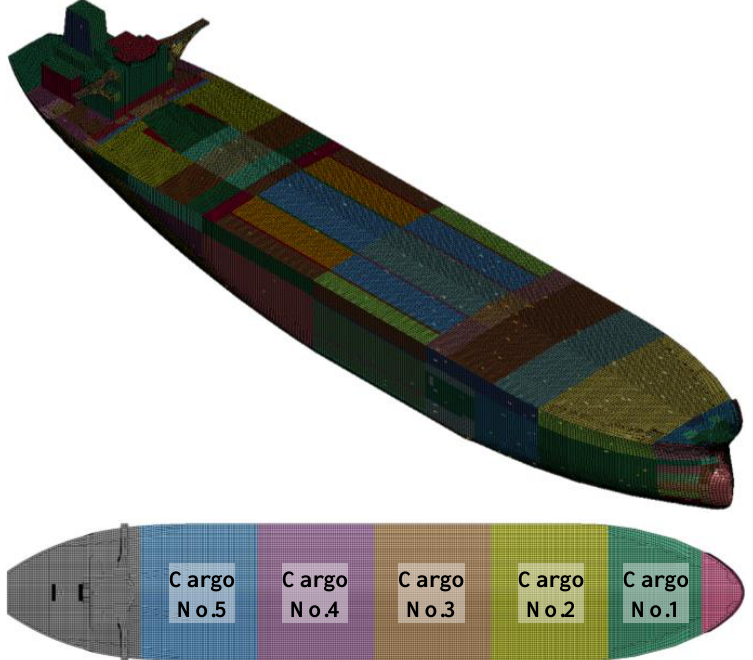
Figure 2. Target structure: 320 k VLCC class double hull oil tanker.